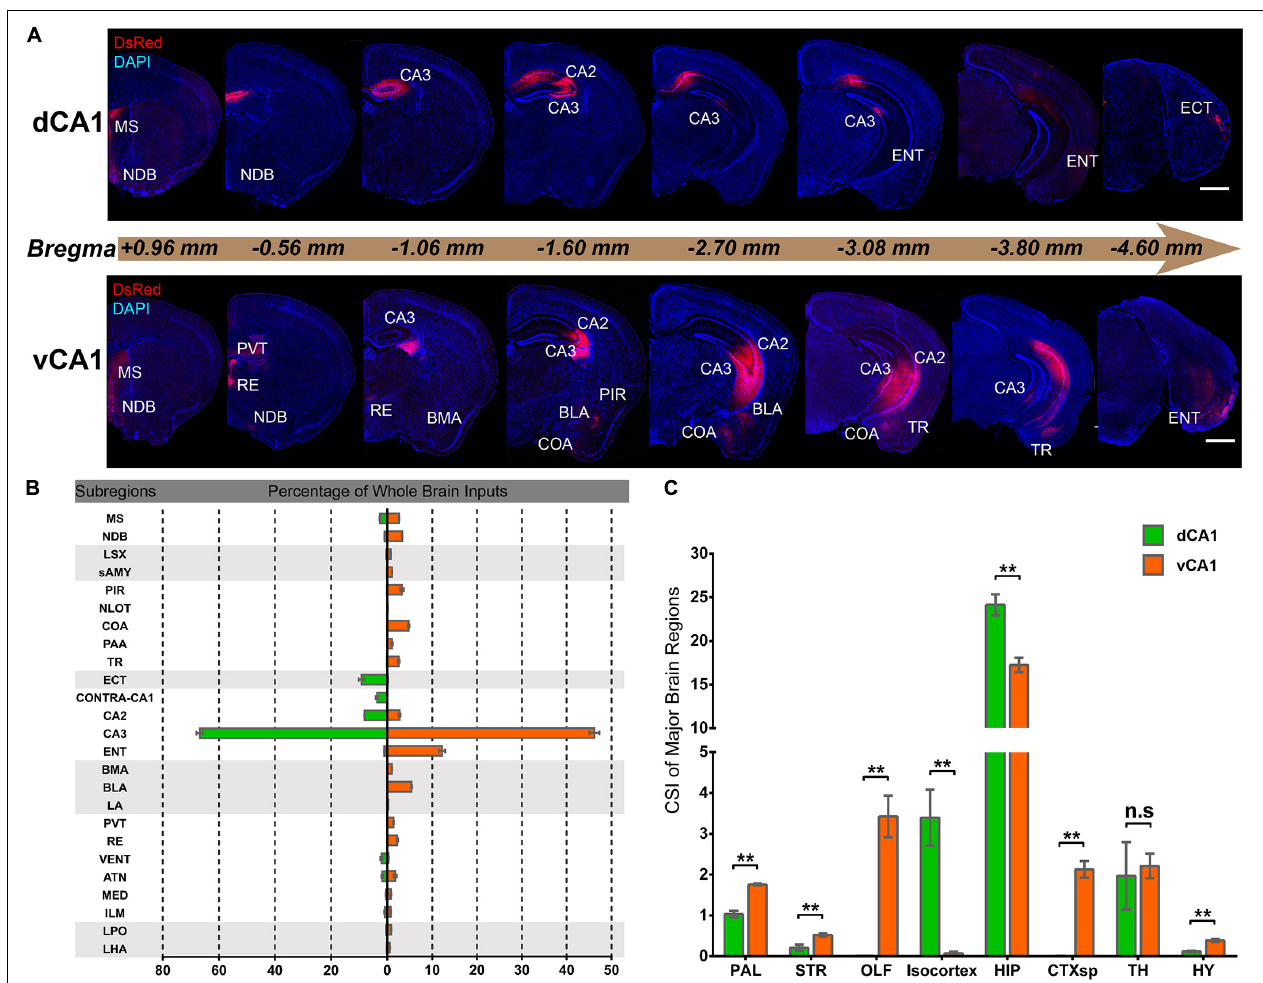
FIGURE 2 | Distribution patterns of whole-brain inputs to dorsal or ventral CA1 PNs. (A) Representative coronal sections showing labeling of monosynaptic inputs to the dorsal or ventral CA1 PNs along the RC axis. Scale bar: 1 mm. (B) The proportion of input neurons within subregions of the whole brain in two tracing groups, quantified with all slices (left, dCA1 tracing group; right, vCA1 tracing group). (C) The CSI of eight major input brain regions, quantified with all slices. n.s., no significant difference; ** P <